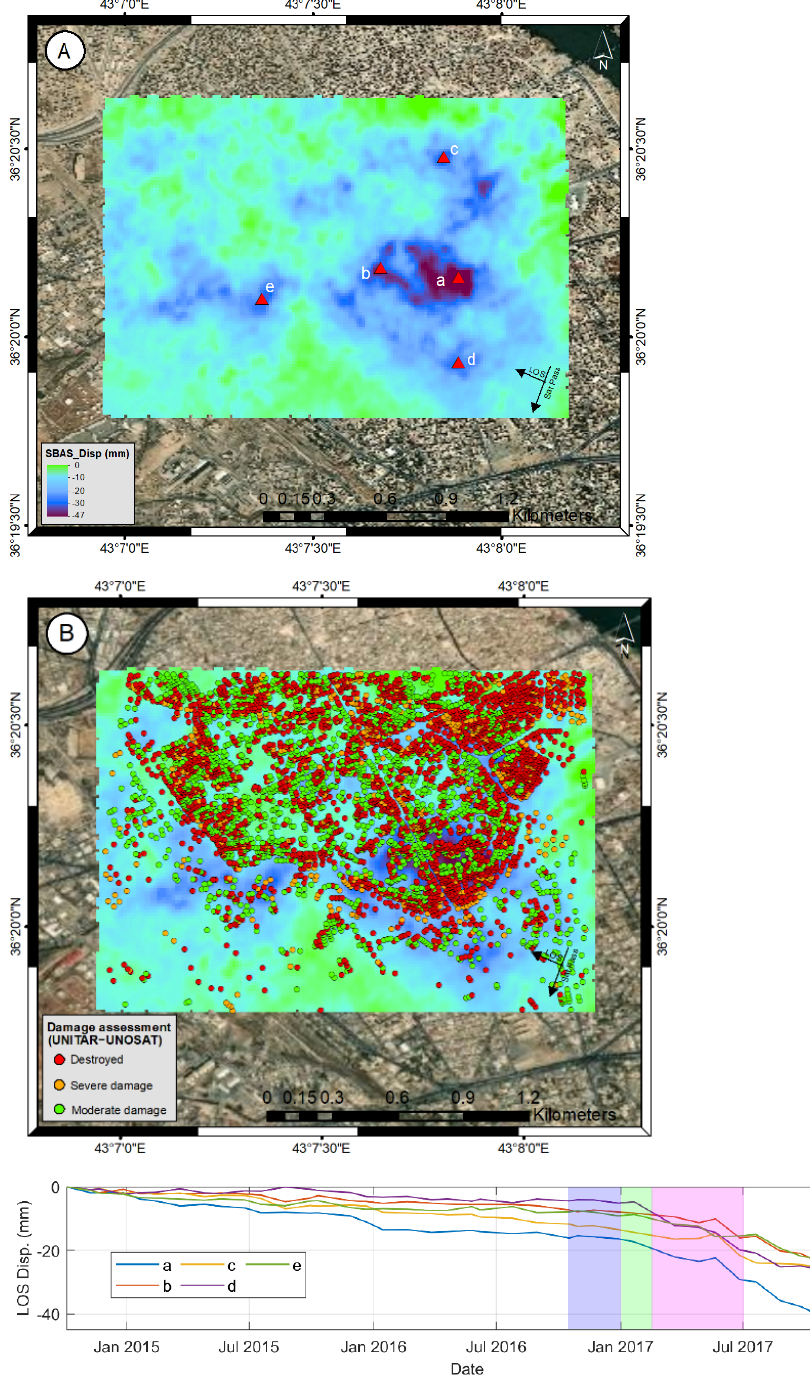
Figure 4. Trends in SBAS-displacement and their relation to war events. ( A ) Zoomed view of rectangle "c" on Figure 3A with five selected points. ( B ) The damaged buildings detected by the UNITAR-UNOSAT classified as the destroyed build- ings (red points) superimposed over the SBAS-displacement map. The SBAS pixels with no corresponding red points have been masked. ( C ) SBAS-displacement time series images of the selected points on Figure 4A plotted along with the time- span of the three phases of the recapture operation of Mosul; phase 1 (purple), phase 2 (green), and phase 3 (pink). Further information on the timeline of the retake operation of Mosul can be found in Battle of Mosul on Wikipedia.